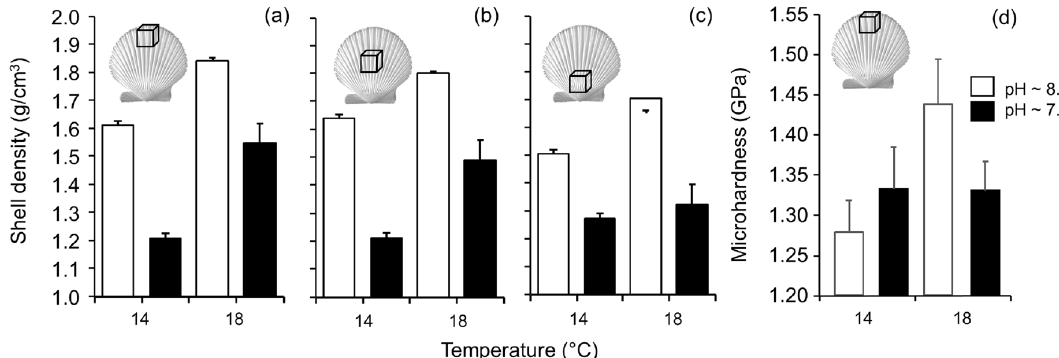
Figure 4. Influence of temperature and pH on Argopecten purpuratus shell properties: ( a – c ) Shell density (mean ± SE) (determined by Micro-CT) at three different regions of the shell; ( d ) micro-hardness (determined by micro-indentation) at the shell growth edge. Different letters in ( a ) represent significant differences among treatments using a post hoc Tukey HSD. Posteriori test was not performed in ( a – c,e ) because the interaction of random with fixed